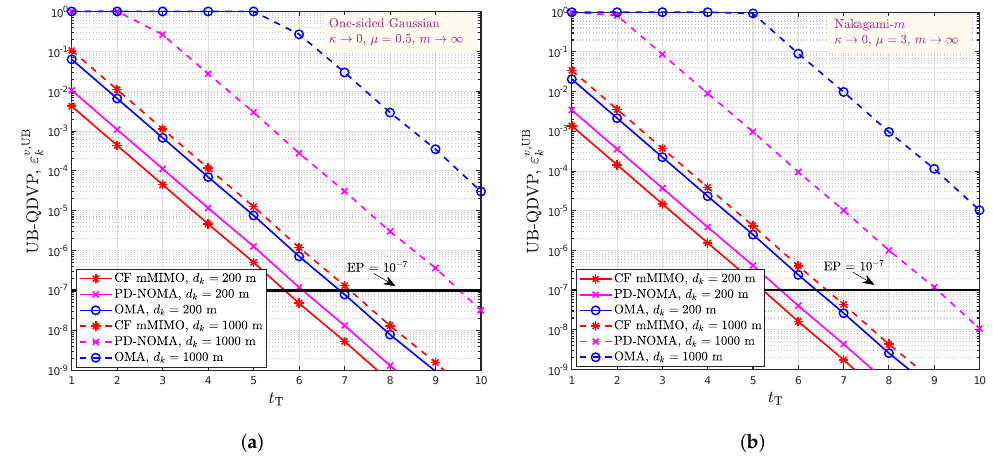
Figure 6. Comparison of the UB-QDVPs in the CF mMIMO, PD-NOMA and OMA systems. ( a ) Comparison of different communication systems under One-sided Gaussian fading; ( b ) Compari- son of different communication systems under Nakagami- m